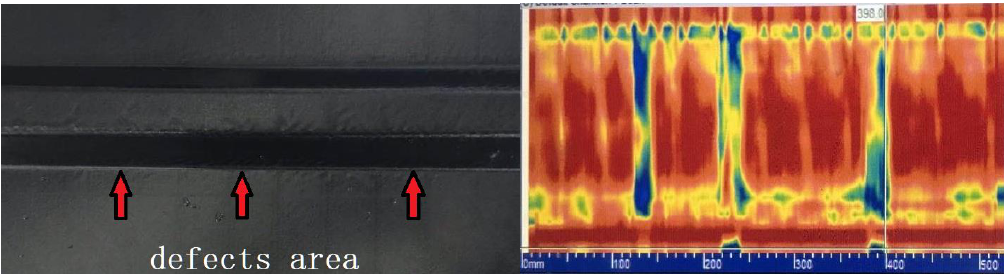
Figure 21. Distribution of prefabricated defects in the R-zone and corresponding phased array inspection C-type diagram.